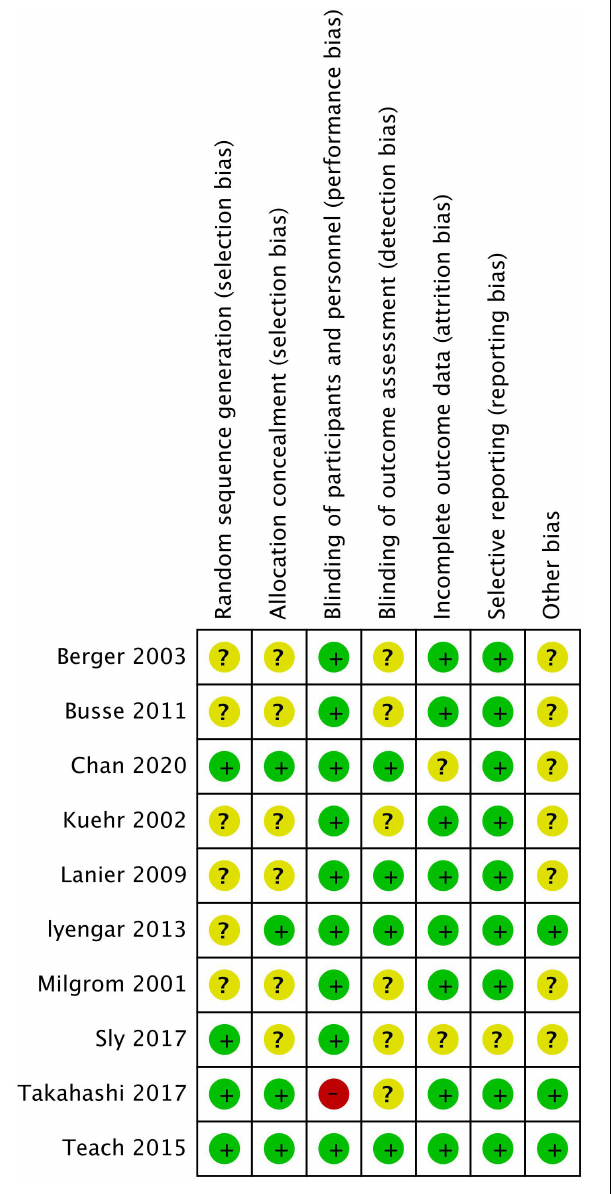
FIGURE 3 | Risk of bias